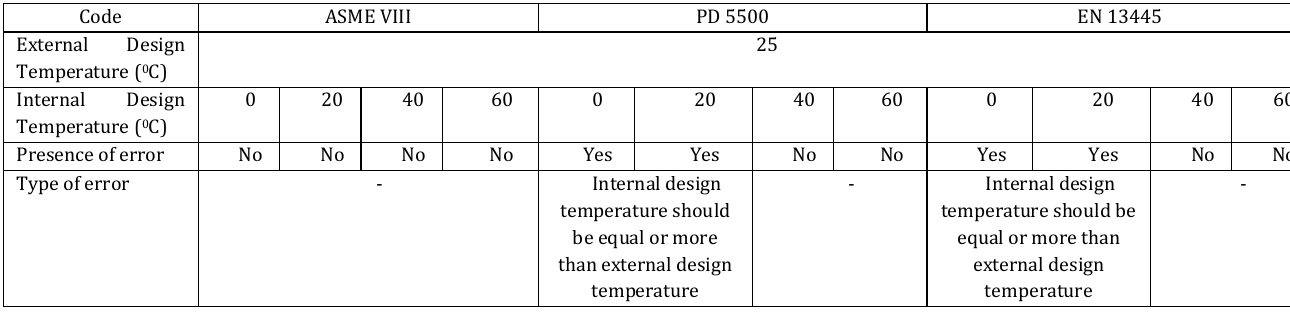
Table 3: Summary of simulation using